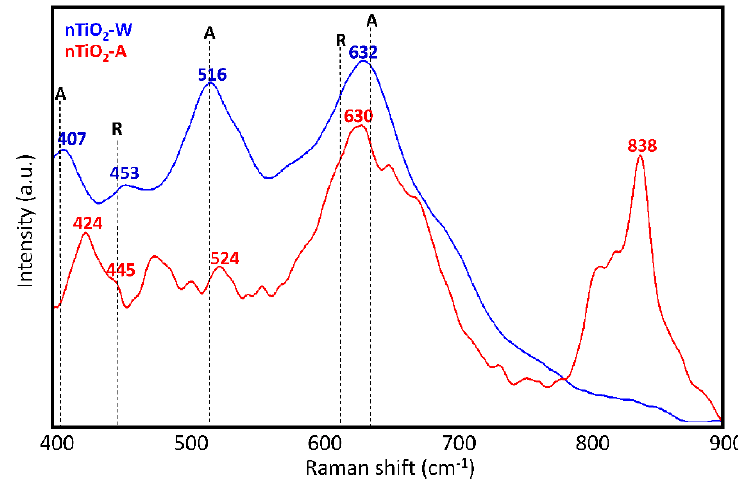
Figure 3. Raman spectra of dry TiO 2 dispersions (nTiO 2 -W and n-TiO 2 -A) with indication of peak positions for anatase (A) and rutile (R) crystals.